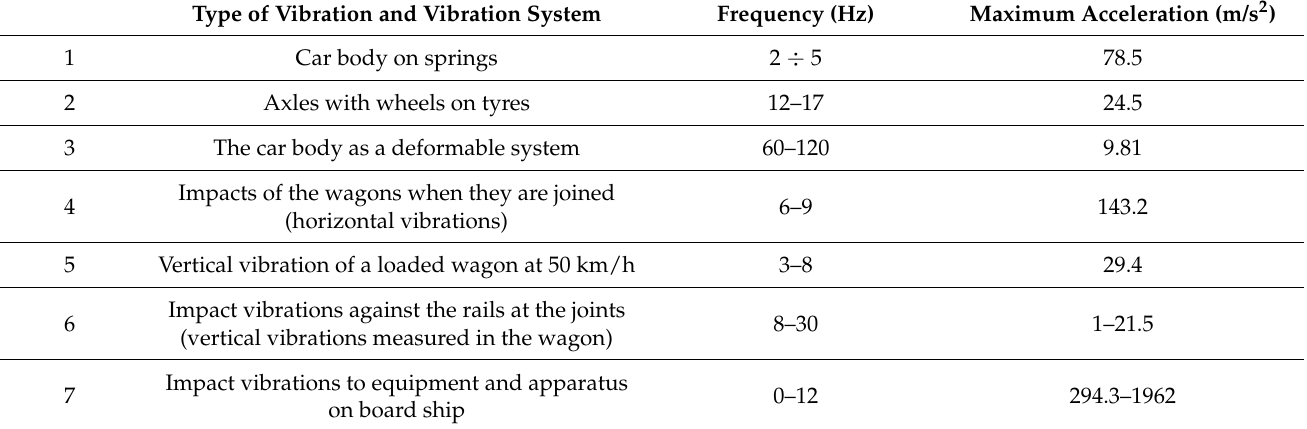
Table 1. Vibration occurring in selected vehicles.